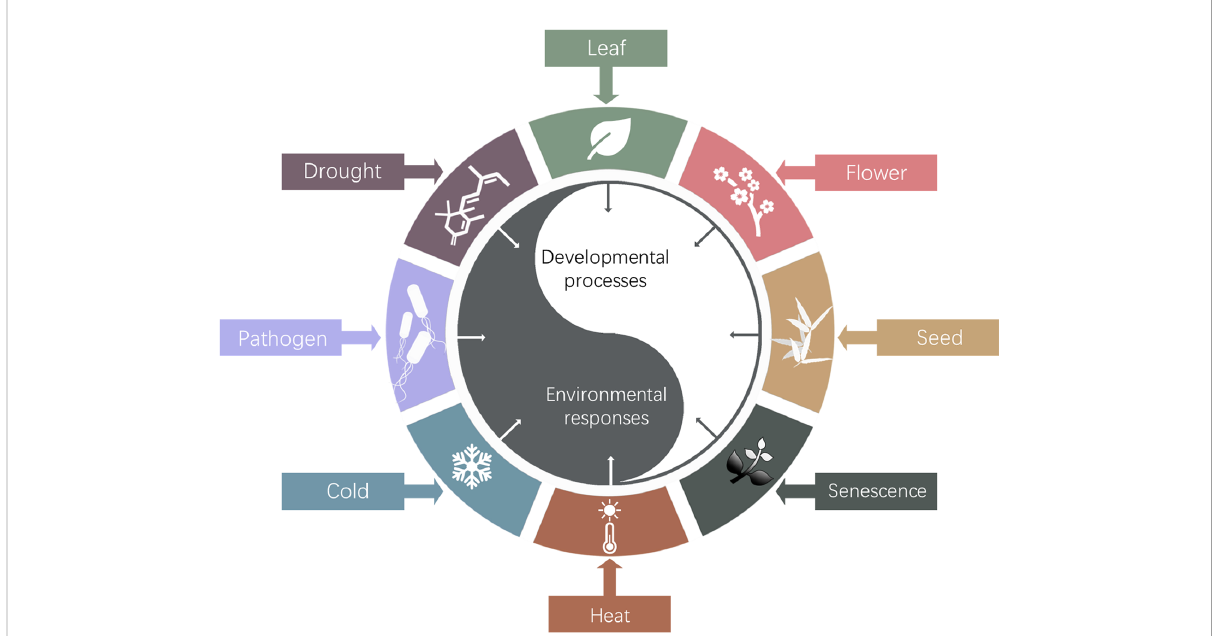
FIGURE 3 Schematic diagram of HOS15 regulated developmental processes and response to environmental stresses. So far, HOS15 was found to play multiple roles in plant organ development, such as leaf, fl ower, seed and senescence; and plant response to various abiotic and biotic stresses, such as drought, temperature, and